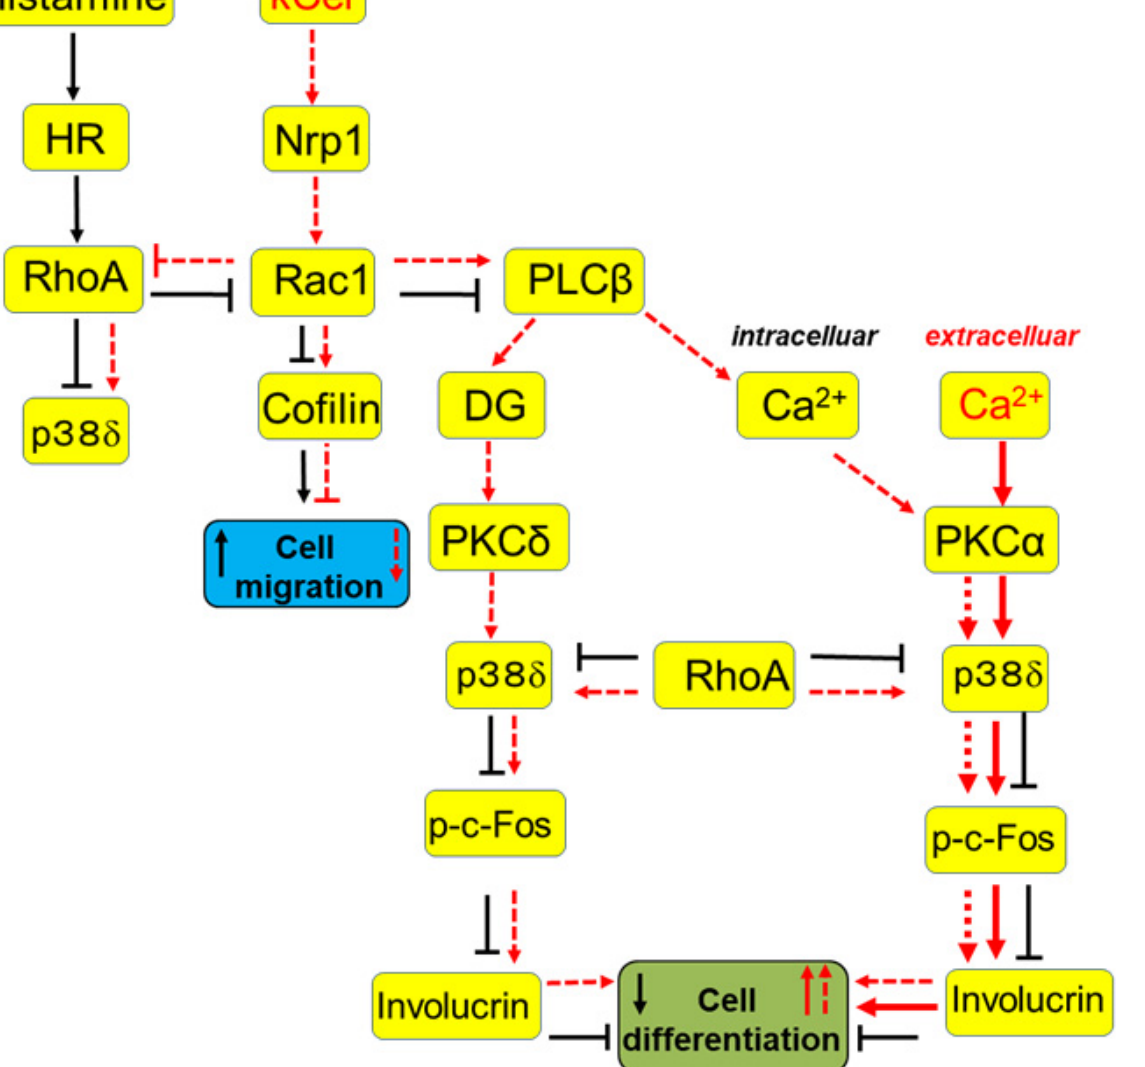
Figure 6. Proposed mechanism of signaling crosstalk between Sema3A-Nrp1 and HR pathways. Results of stimuli by histamine and high extracellular Ca 2+ are reflected in the possible mechanisms for kCer regulation of cell migration and differentiation. HR, histamine receptor; Nrp1, neuropilin1; DG, diacylglycerol. Black arrows, activations via histamine; broken-lined red arrows, activations by kCer; thick-lined red arrows, activations by high Ca 2+ ; , suppression via histamine. , suppression via kCer.